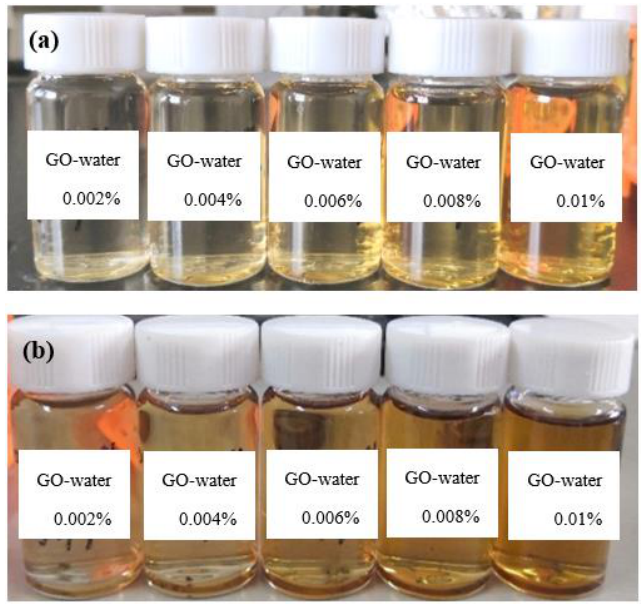
Figure 1. Nanofluids with different concentrations ( a ): 0 d and ( b ): 20 d.